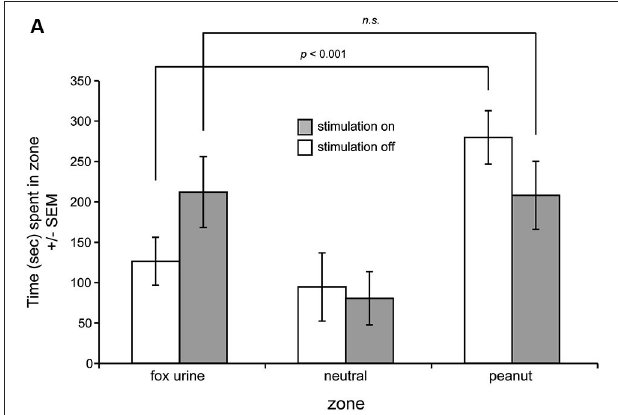
FIGURE 3 | OT stimulation alters odor-guided behaviors. (A) Mice were allowed to explore a three-chamber odor preference chamber for 10 min with one side containing crushed peanuts (3 g) and the other fox urine (1:10 dilution) both contained within a perforated dark plastic container. On counterbalanced days, current stimulation was delivered throughout the entire duration of the session. On the day with stimulation off, mice spent significantly greater time in the peanut zone, whereas this was abolished with OT stimulation on. n = 6 mice. n.s. = not significant. p -values = ANOVA followed by Fisher’s